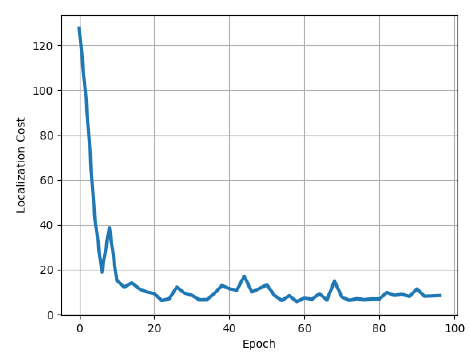
Figure 6. Palmprint localization cost versus epochs.